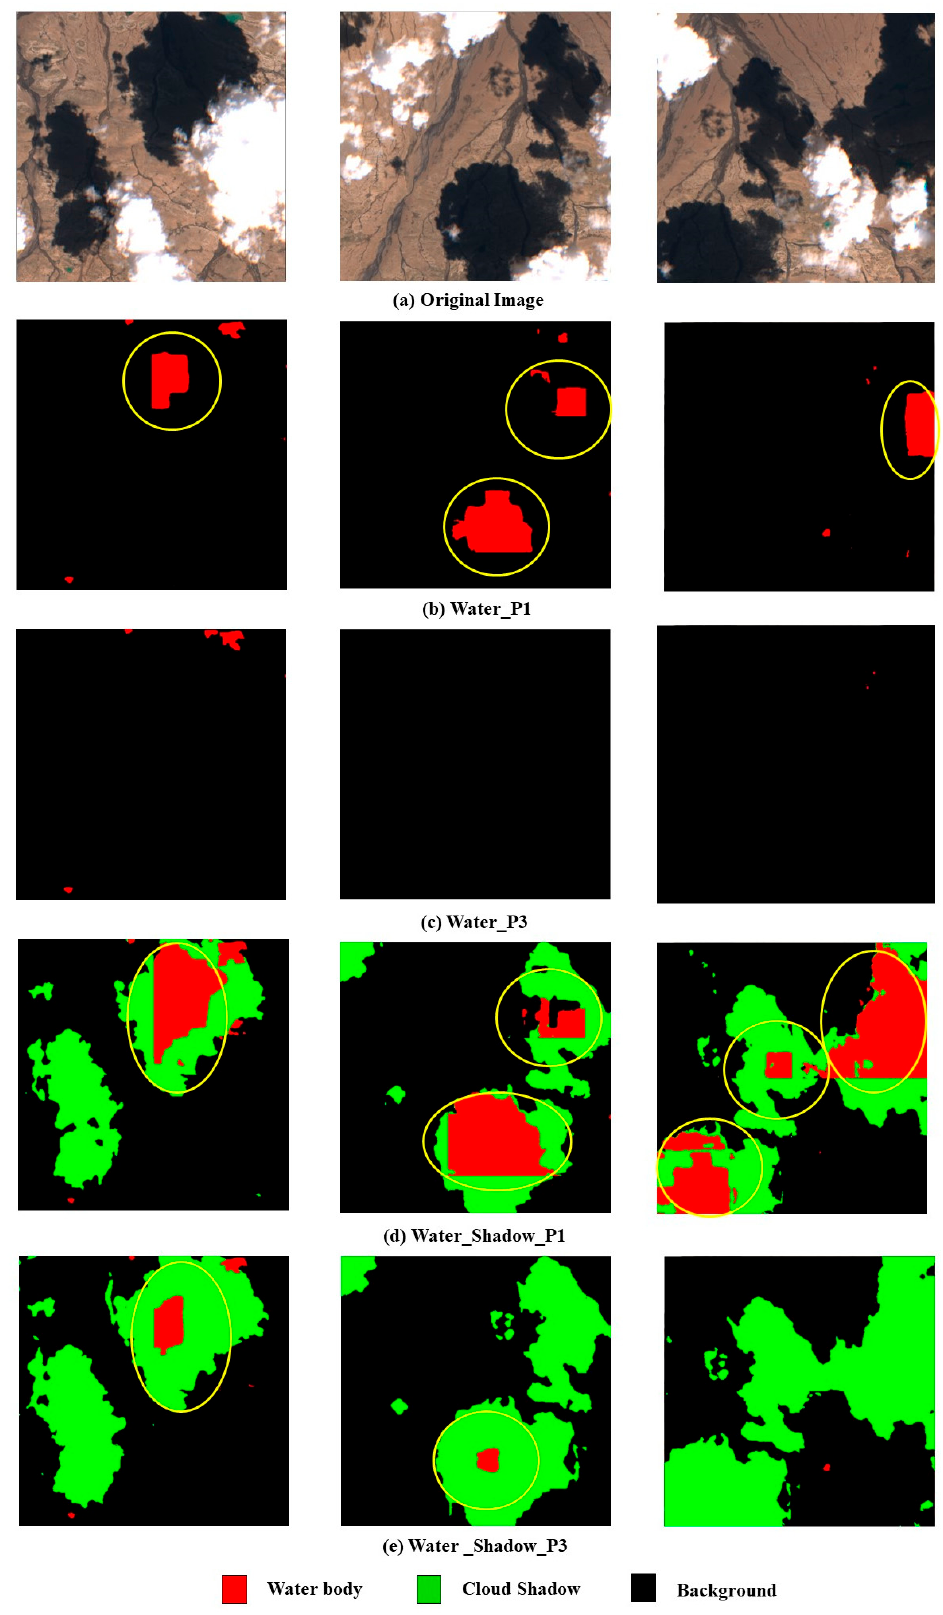
Figure 4. Results of cloud shadows being misclassified as water bodies (The areas circled in yellow represent the cloud shadows being misclassified as water bodies).